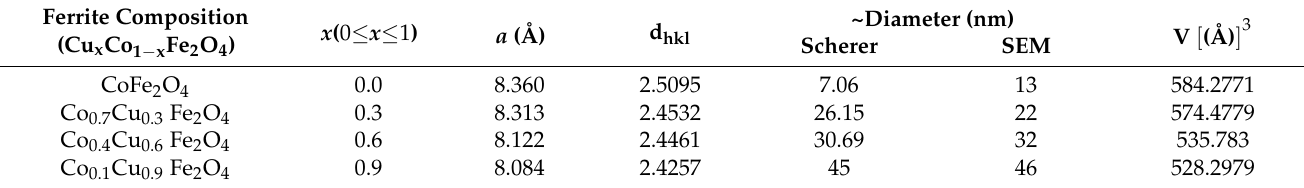
Table 2. The values of lattice parameter, diameter and volume of plant-extracted pure cobalt ferrite nanoparticles and copper-substituted cobalt ferrite nanoparticles. Ferrite